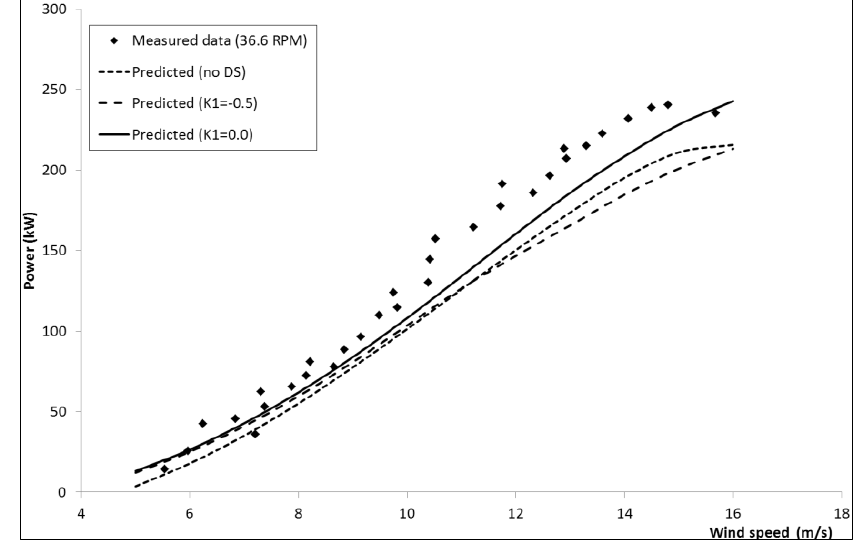
Figure 9. NRC 24m Φ-rotor power vs. wind speed at 36.6